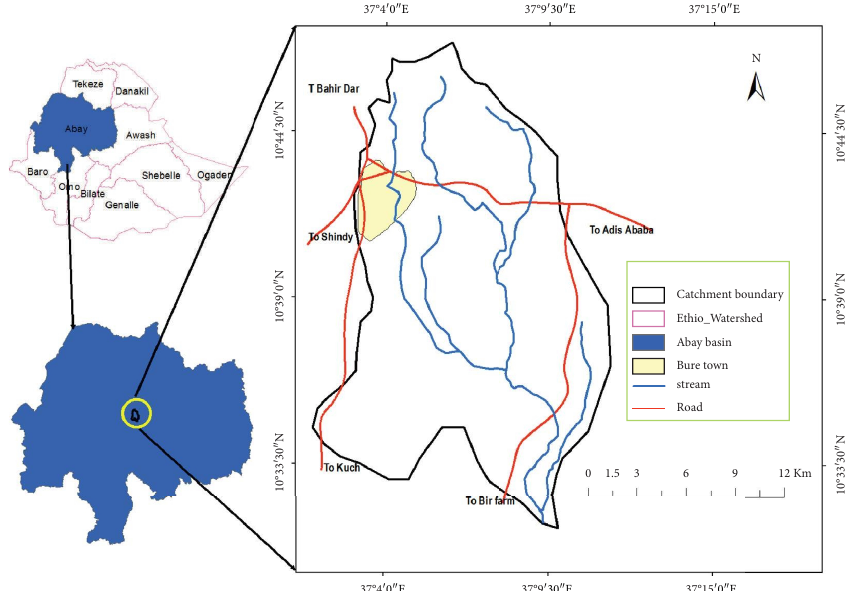
Figure 1: Location map and accessibility of the study area.